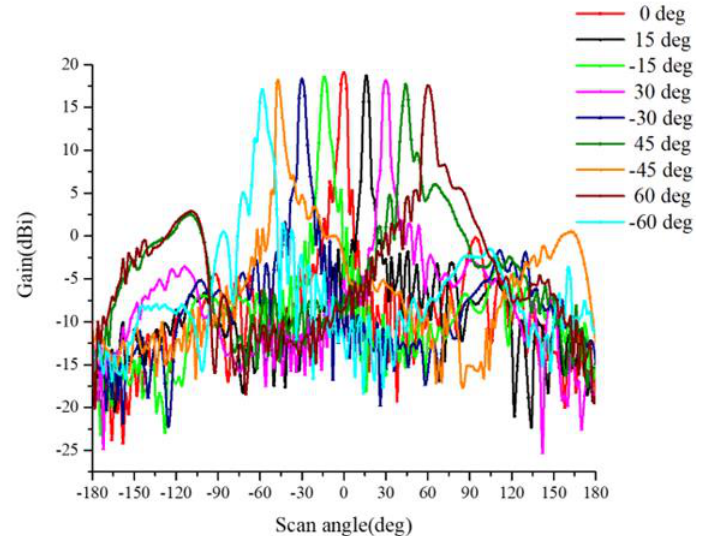
where ( θ 0 , ϕ 0 ) is the scanning angle, and ( x i , y i , z i ) represents the coordinate of the i th element. With the coordinate system shown in Figure 6, the scanning angles in the azimuth plane have θ 0 of 90 ◦ . Figure 7 shows the simulation patterns for different scanning angles at the center frequency 15.6 GHz. Since the scanning performances of the array for horizontal polarization and vertical polarization are similar, only the patterns for the horizontal polarization are given.